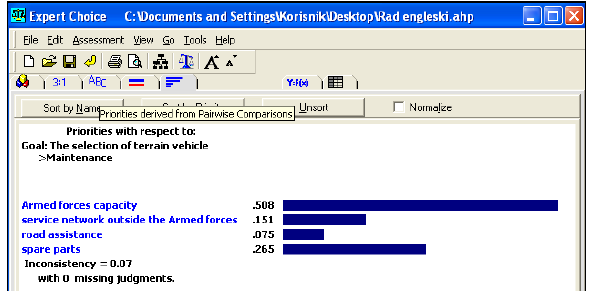
Figure 10. Maintenance